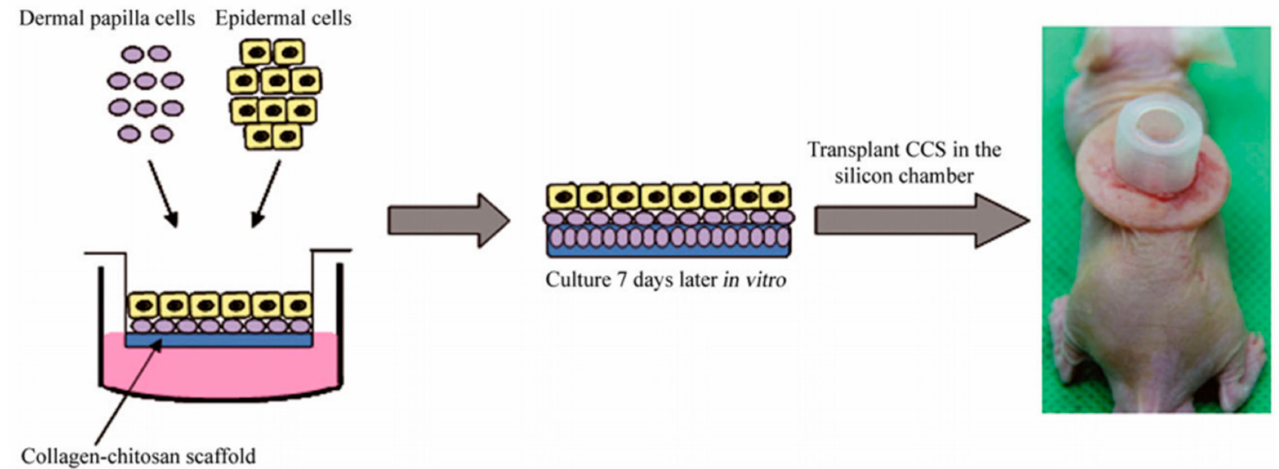
Figure 7. Schematic representation of inoculated DPCs and epidermal cells being transplanted in the silicon chamber on the back of a nude mouse. Reproduced with permission from